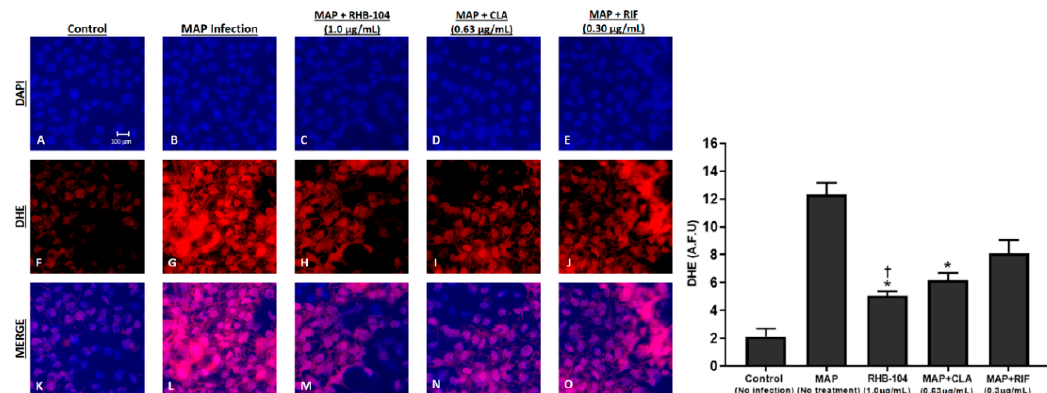
Figure 8. Oxidative stress levels demonstrated by DHE fluorescence staining assay following treatment with RHB-104 and its major components in MAP infected Caco-2 Monolayers. Total nuclei are stained with DAPI in blue ( A – E ). DHE positive cells are stained in red ( F – J ), and merged cells are presented in pink ( K – O ). The histogram shows quantitative corrected DHE fluorescence integrated density in control and treated groups. * p value < 0.05 compared to no treatment control. † p value < 0.05 compared to no treatment control and MAP + RIF values.